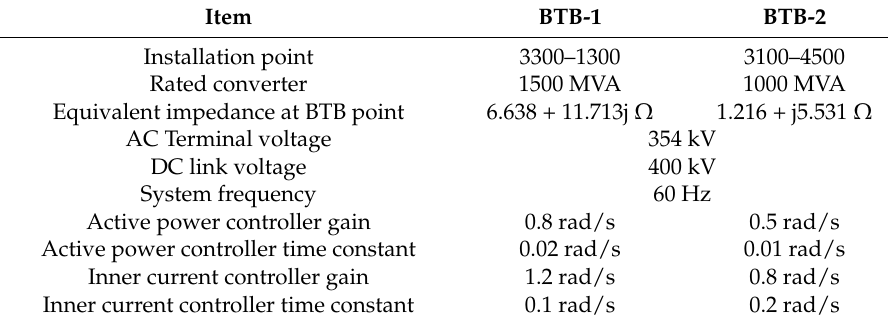
Table 1. System parameter of BTB VSC.